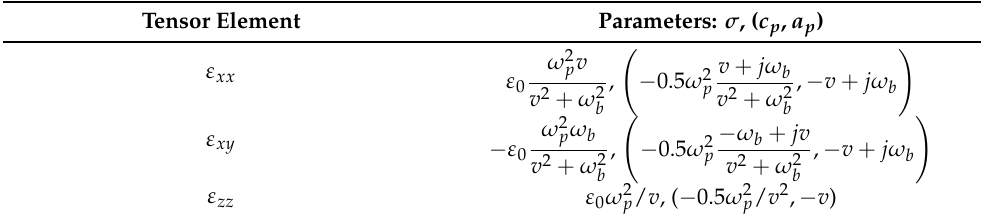
Table 2. CCPR parameters for magnetized plasma.